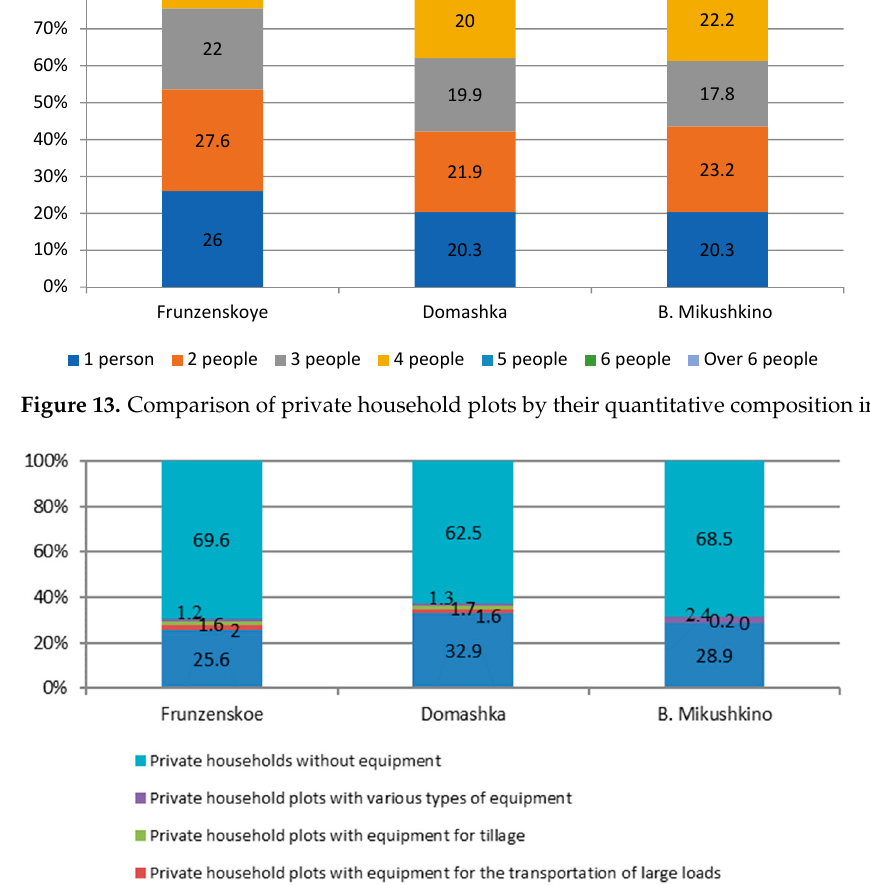
Figure 13. Comparison of private household plots by their quantitative composition in 2014–2018.